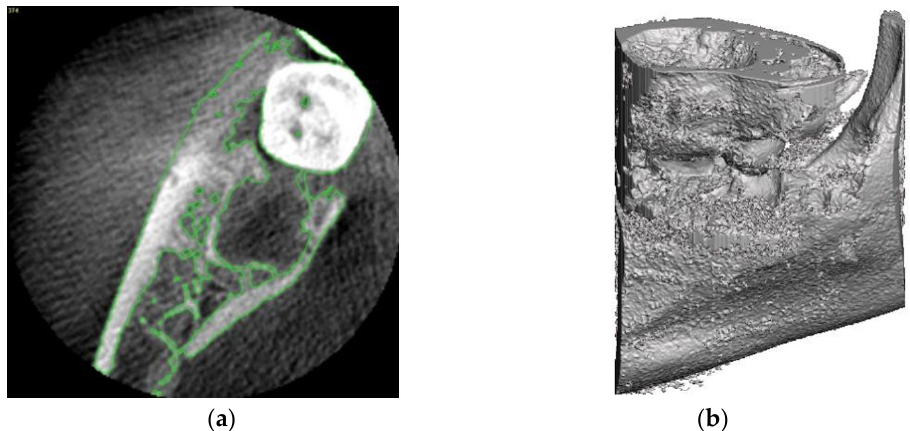
Figure 5. ( a ) Segmentation on the CBCT image and ( b ) reconstructed surface 3D model of the jaw.